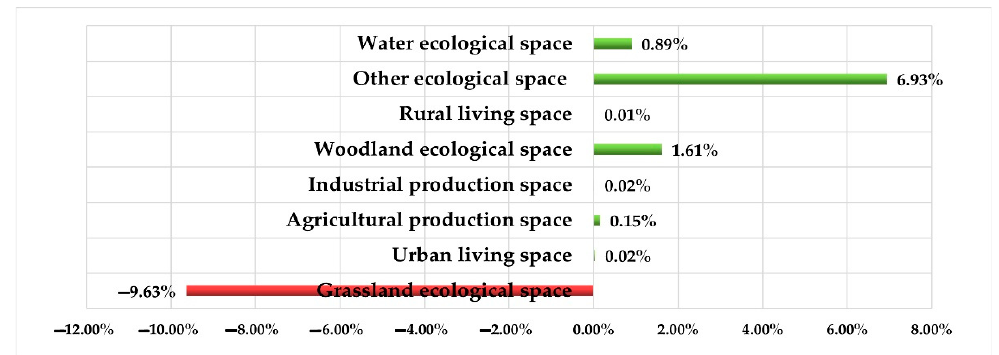
Figure 8. The ratio of land-use conversion area from 1980 to 2020.